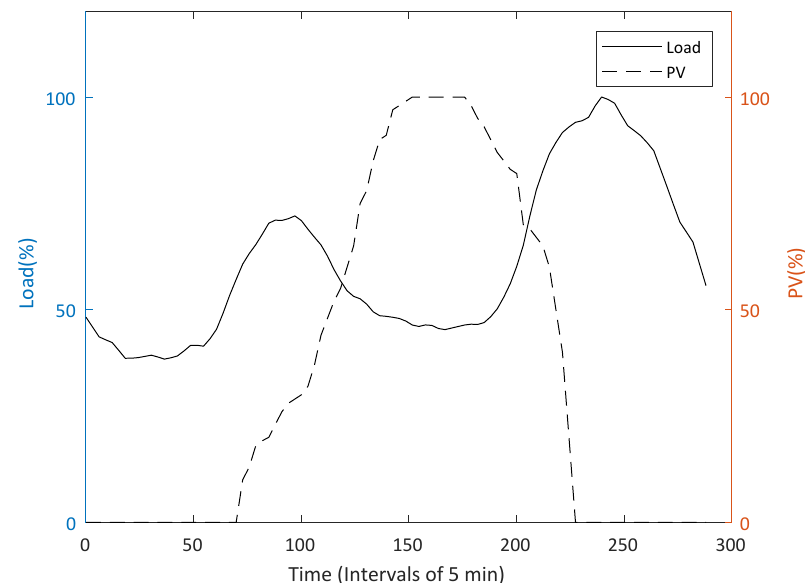
Figure 8. Load profile and PV profile.